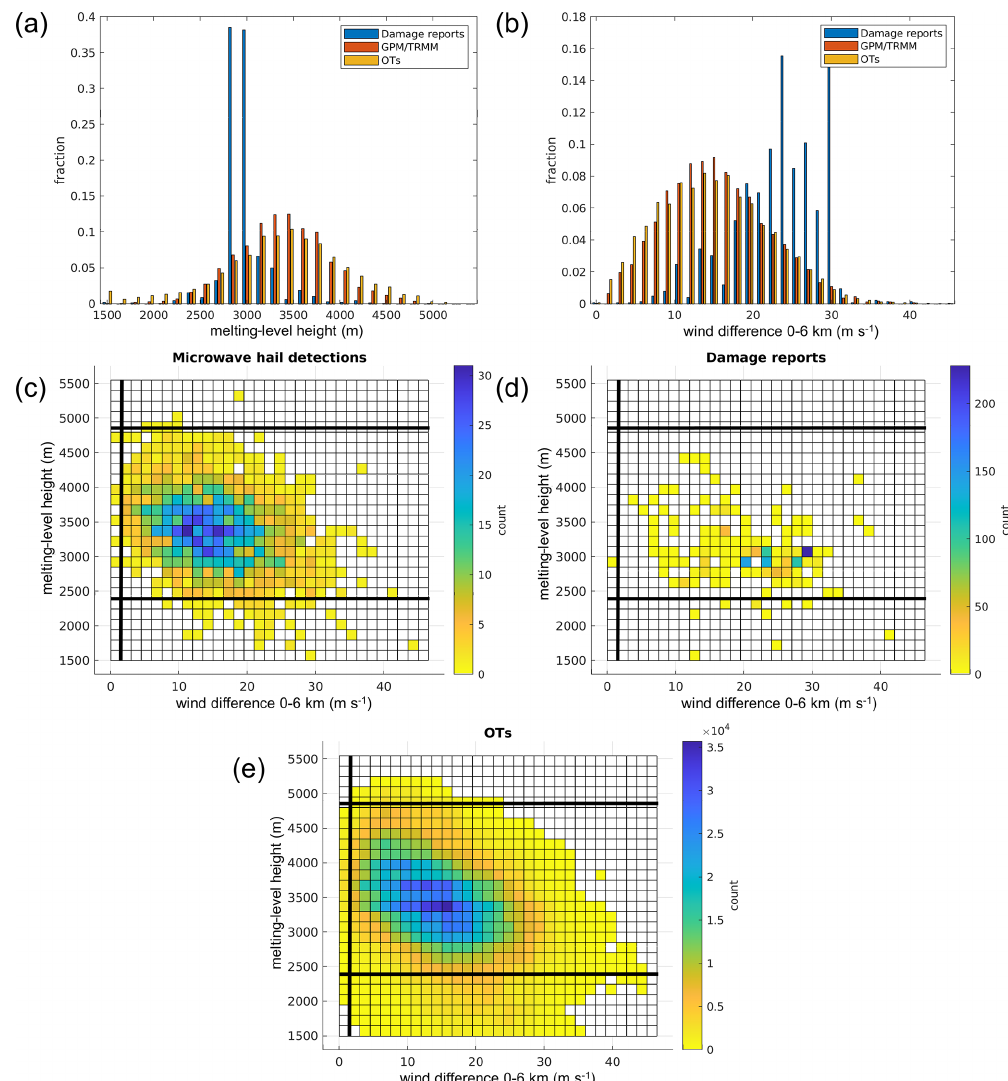
Figure 5. Distribution of the ERA5 0–6km wind difference and melting-level height in hail claims (1984–2017), passive microwave detec- tions (1998–2019), and OTs (2005–2018) for South Africa and Lesotho. (a, b) Probability distribution and (c–e) bivariate histogram for the 0–6km wind difference and freezing level for (c) microwave hail detections, (d) damage reports, and (e) OT detections (bold lines indicate the selected filter thresholds; see text for further details). Only situations with positive CAPE in ERA5 were used for these